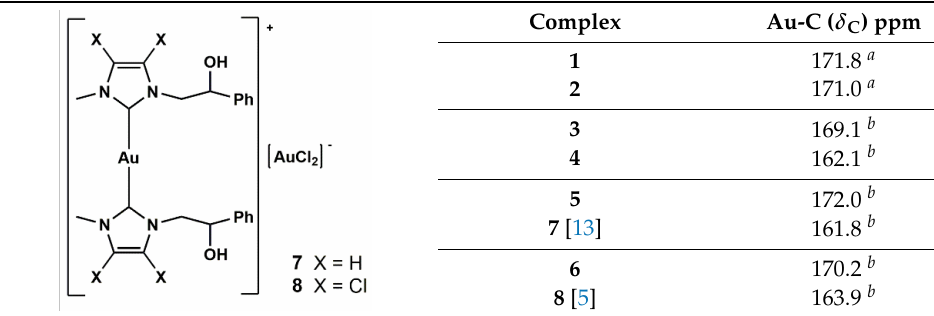
Table 1. Carbene carbons data for 1 – 8